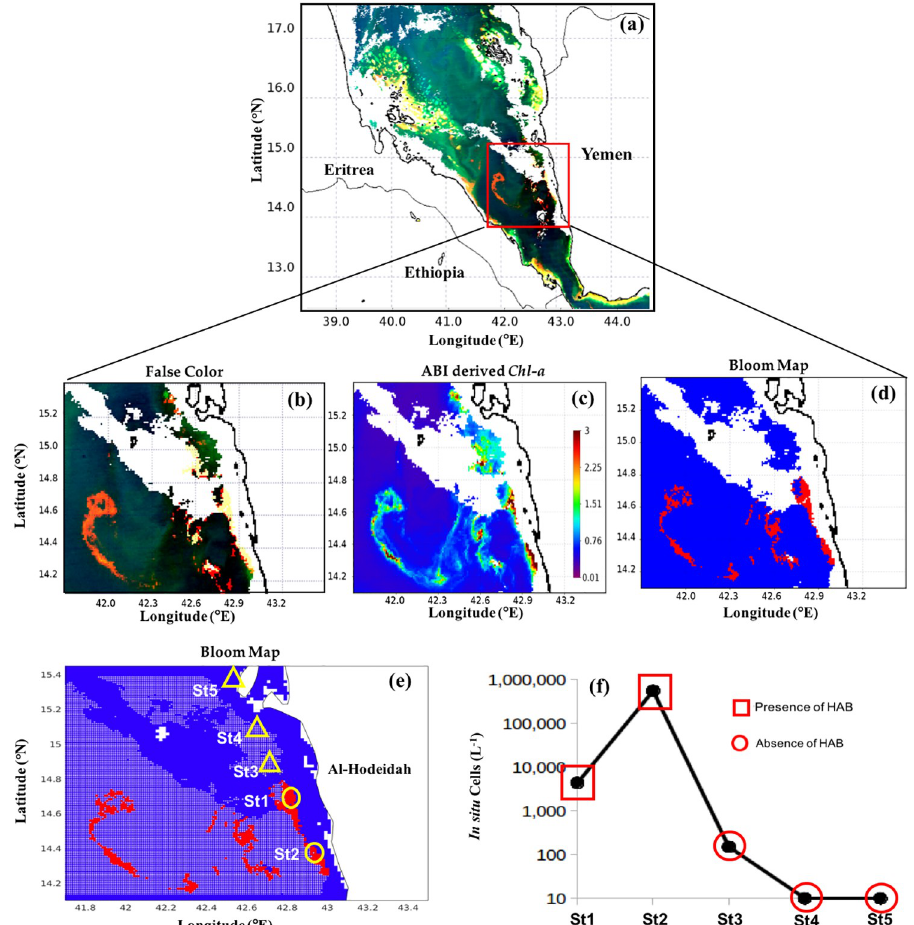
Fig 10. Remotely sensing N . scintillans/miliaris blooms in the southern Red Sea and comparison with in situ measurements. (a) and (b) False color composite image generated using the NIR, green and blue reflectances (i.e., R = R rs (748), G = R rs (547), B = R rs (443)). (c) Satellite-derived Chl-a using ABI algorithm. (d) and (e) MODIS-Aqua- derived maps of the N . scintillans/miliaris blooms in the Red Sea on 3 rd March 2009 [In (e) the red and white dots denote the presence and absence of HABs, respectively, as detected using satellite data. Also, the yellow circles and yellow triangles indicate the in situ sample points and highlight the presence and absence of N . scintillans/miliaris blooms, respectively]. (f) Variations in N . scintillans/miliaris cell counts recorded from the five different stations in the coastal waters of Yemen, southern Red Sea during 3 rd March 2009 [red squares and circles denote satellite detection of HAB presence and absence,